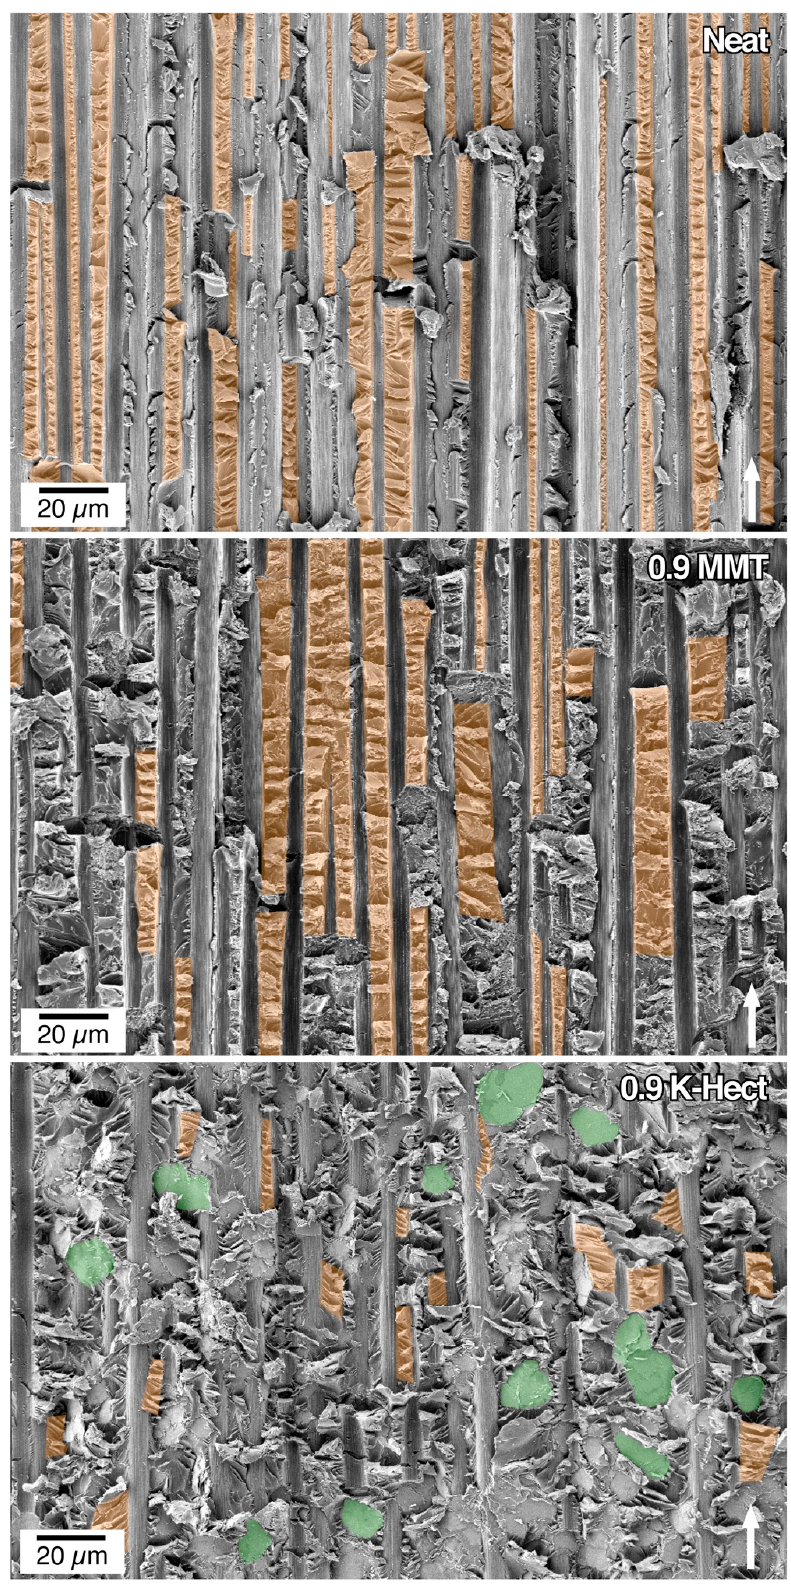
Figure 11. SEM pictures of fracture surface of end-notched-flexure samples (filler content in vol % is given in pictures). The white arrow shows the direction of crack propagation. Orange: hackling regions, green: K-Hect particles.